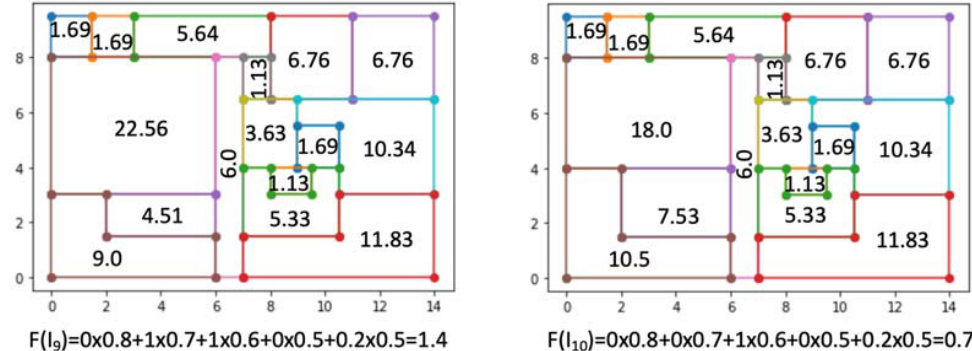
Figure 12. Two very similar and low-rated example floor plans I 9 and I 10 where only REQ2 had a different evaluation value.